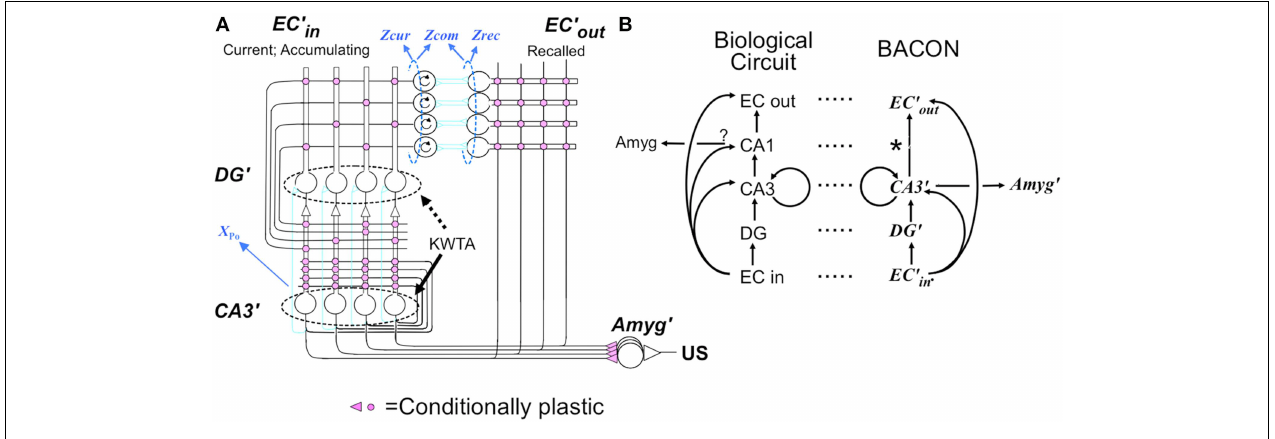
Comparison between biological and BACON circuits. * indicates absence of a CA1 analog in BACON, as various simplifications made its presumed functions redundant (see Results).